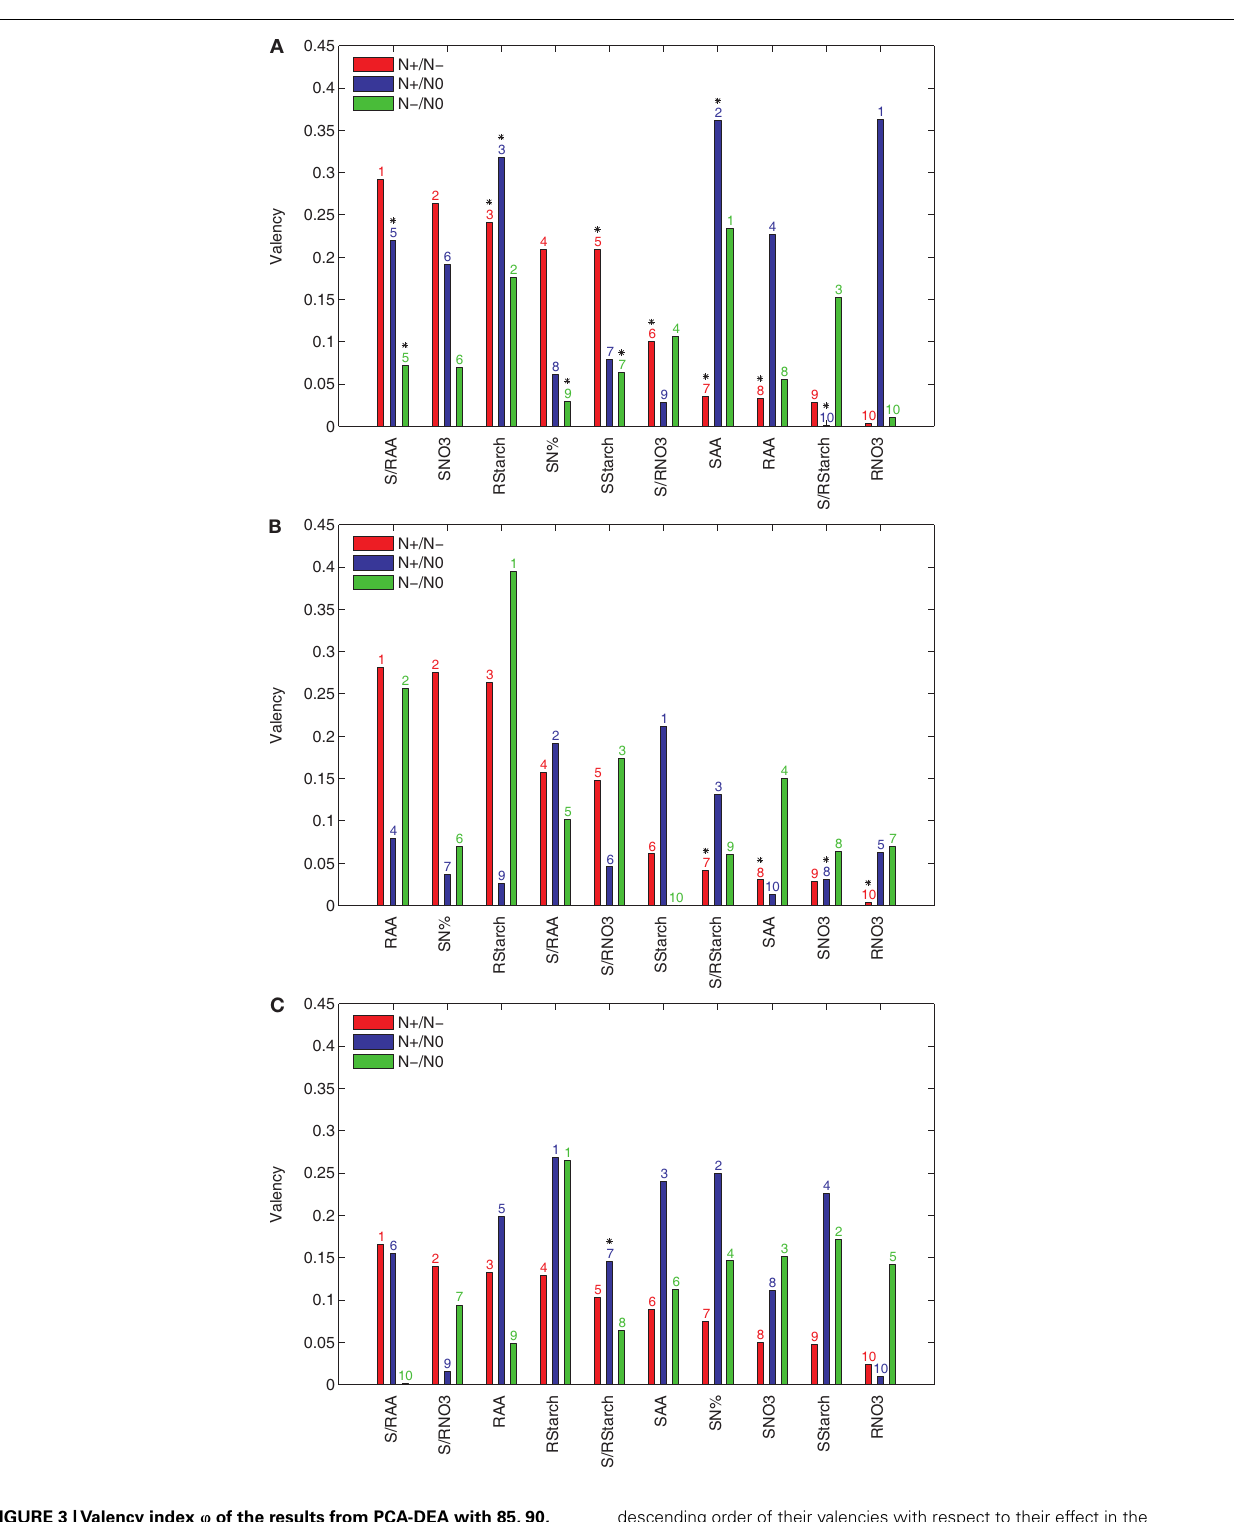
FIGURE 3 |Valency index ϕ of the results from PCA-DEA with 85, 90, and 95% of variance explained. The valency index between the rankings of the relative efficiencies for the 23 accessions are obtained from the pair-wise comparison between the three considered conditions (N + , N − , and N0) with and without a metabolic trait t indicated in the x -axis of each panel when the principal components explaining (A) 85%, (B) 90%, and (C) 95% of the variance are used.The metabolic traits are sorted in a